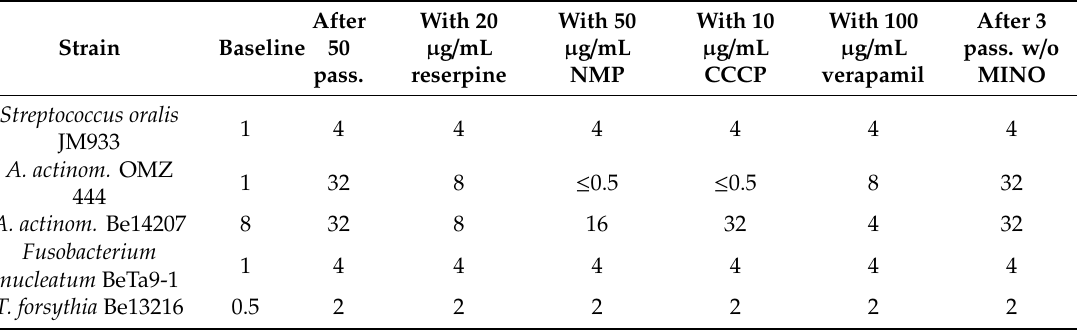
Table 2. MIC of minocycline ( µ g / mL) of strains with changed MIC values after 50 passages on subinhibitory concentrations of minocycline. Presented are MIC values before and after 50 passages, after addition of e ffl ux inhibitors reserpine, NMP, CCCP, verapamil, as well as after additional three passages on agar plates free of